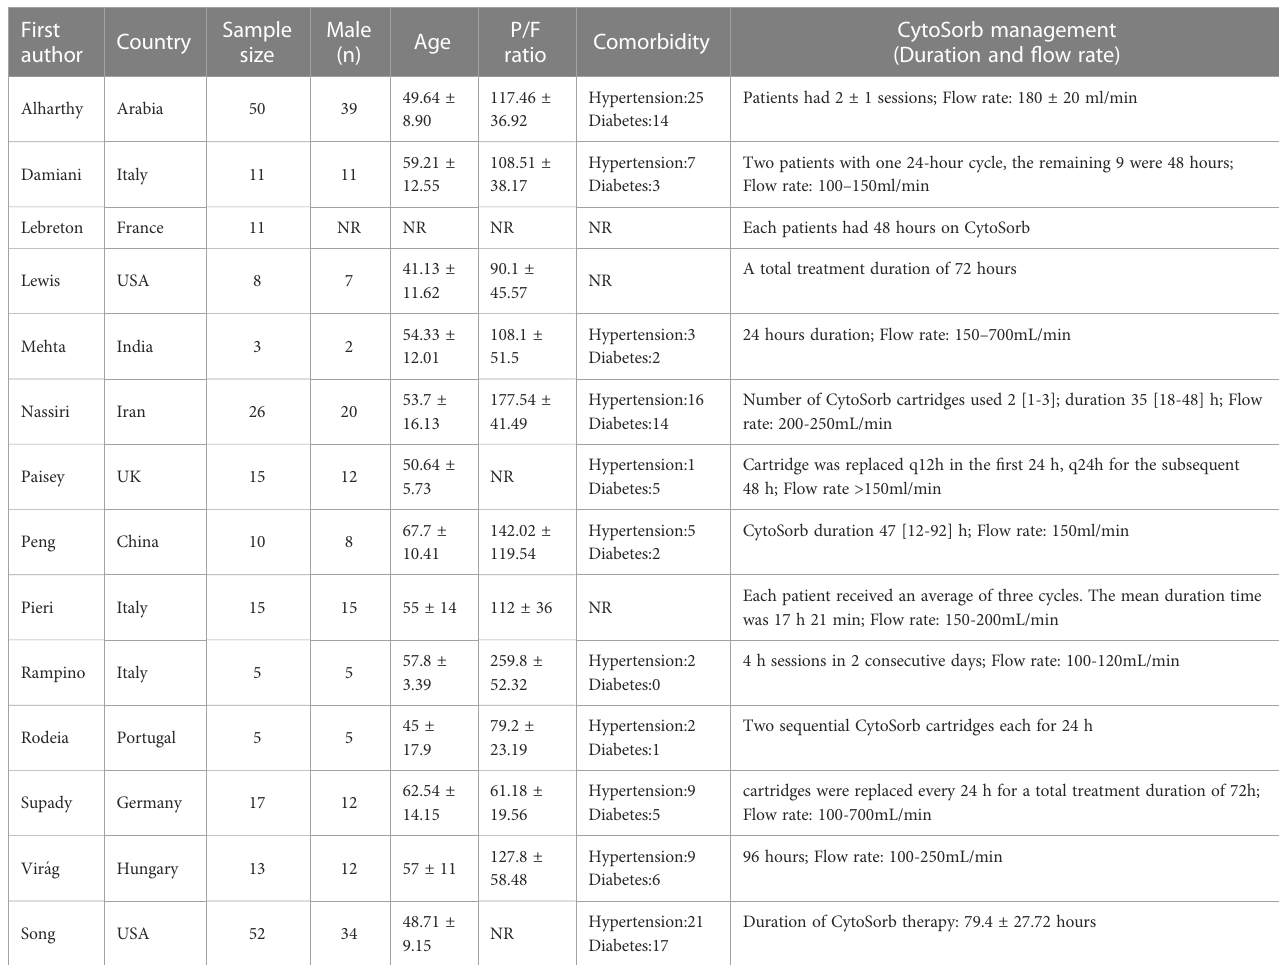
TABLE 1 Demographics of the included